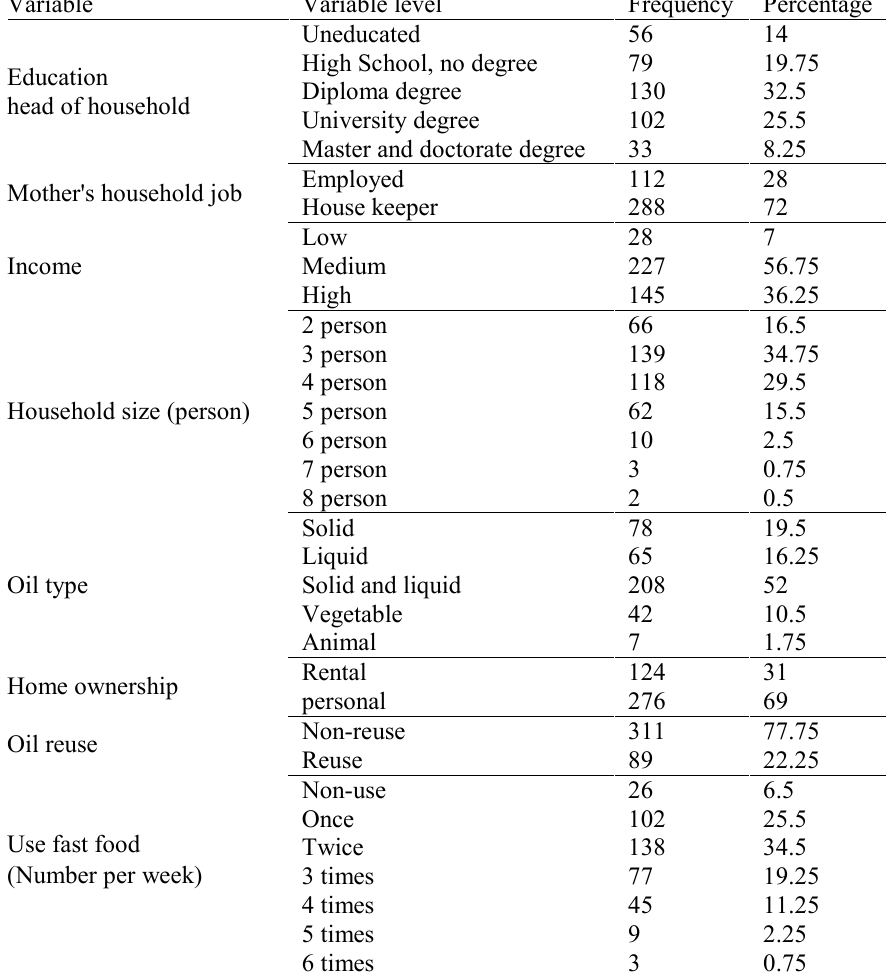
Table 1. Classified factors associated with consumption patterns of edible oils